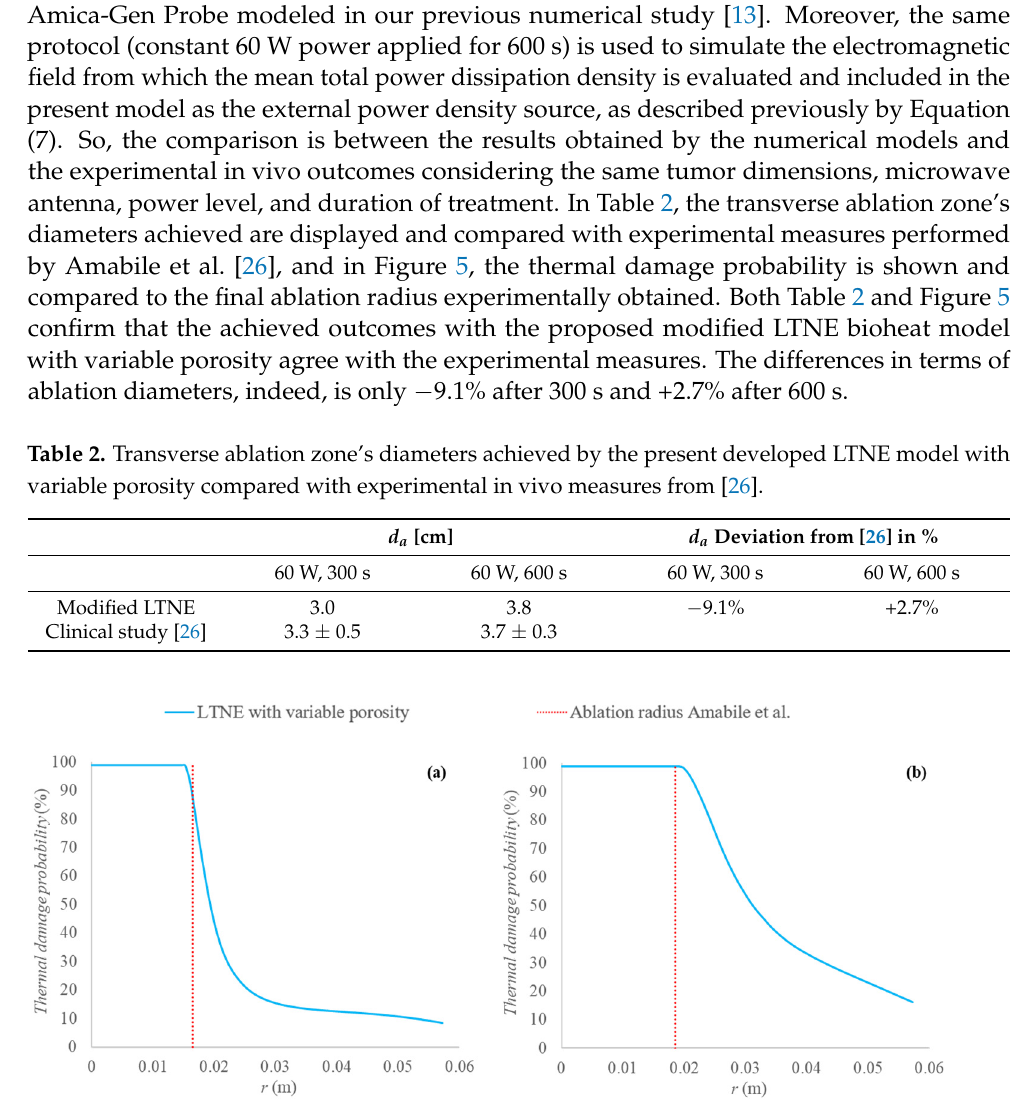
Figure 5. Thermal damage probability in r direction obtained ( a ) after 300 s and ( b ) 600 s treatments by the developed LTNE model with variable porosity. The red dotted vertical line represents the final radius of the ablation zones measured experimentally in vivo by [26].